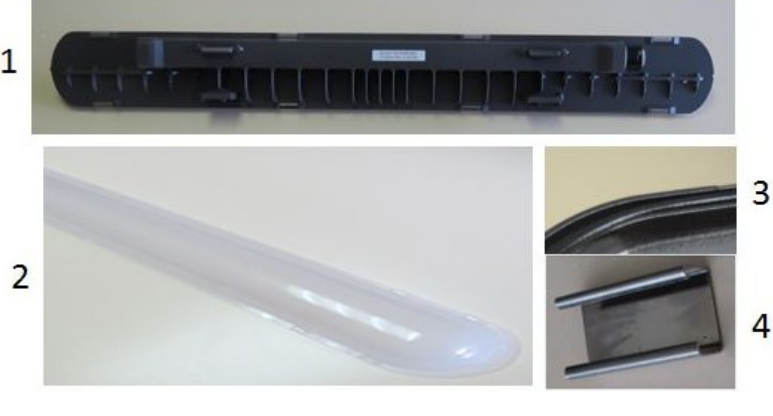
Figure 3. Parts of the light fitting: ( 1 ) housing; ( 2 ) light diffuser; ( 3 ) gasket; ( 4 ) closing